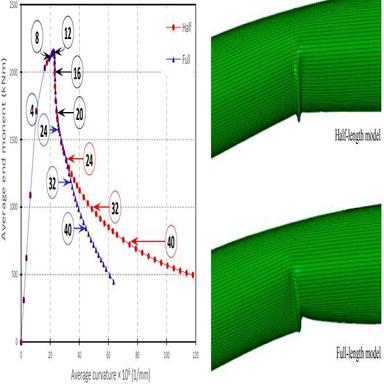
Deformation patterns and comparison of moment–curvature responses for half-length and full-length pipe model.